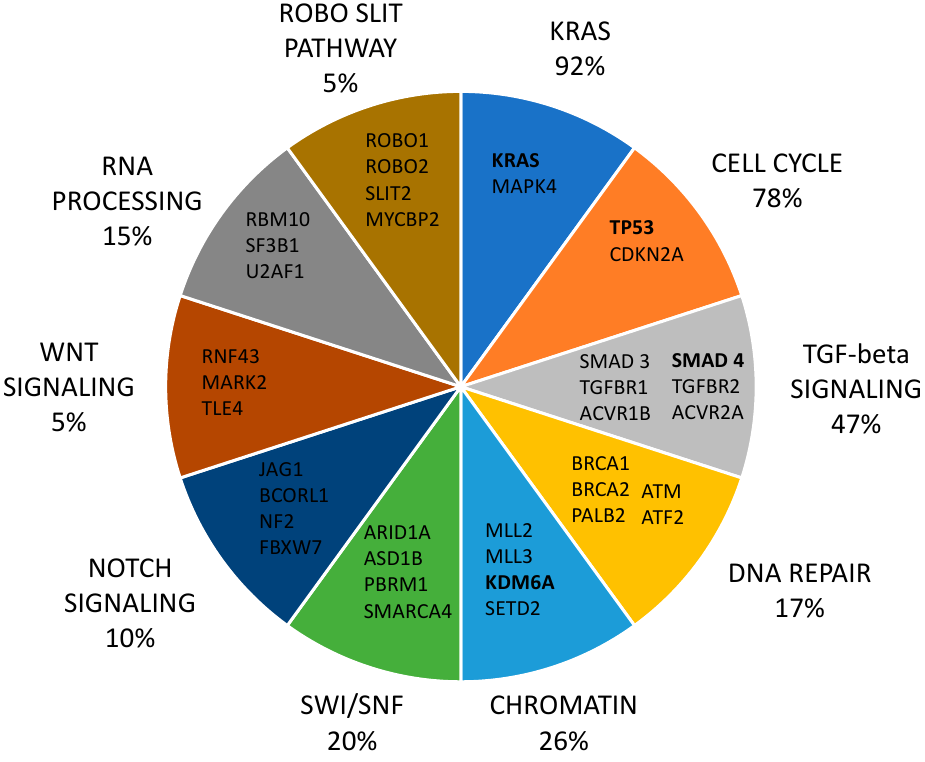
Figure 1. Mutational landscape of pancreatic ductal cancer. The genetic alterations are subdivided into various biochemical pathways, and their global frequency is reported. The most frequent and relevant drivers of pancreatic tumorigenesis are indicated in bold.